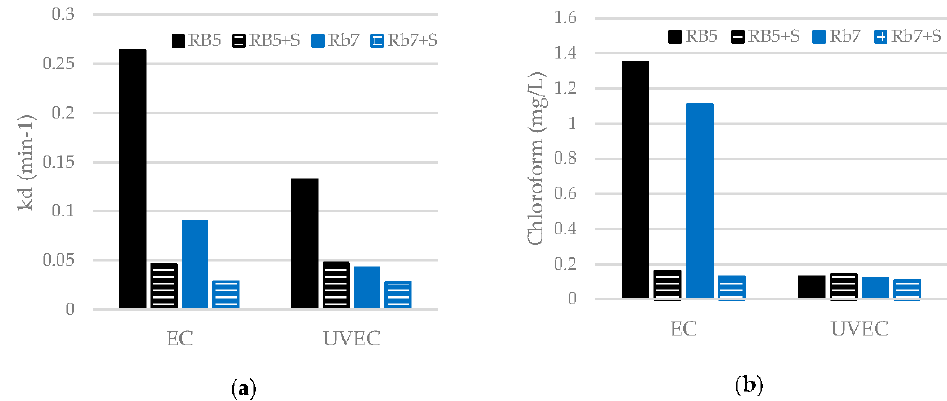
Figure 6. Comparison of the results obtained in the treatments of dyes with respect to the treatments of dye/surfactant mixtures: ( a ) decolorization rate constants; ( b ) chloroform generation.